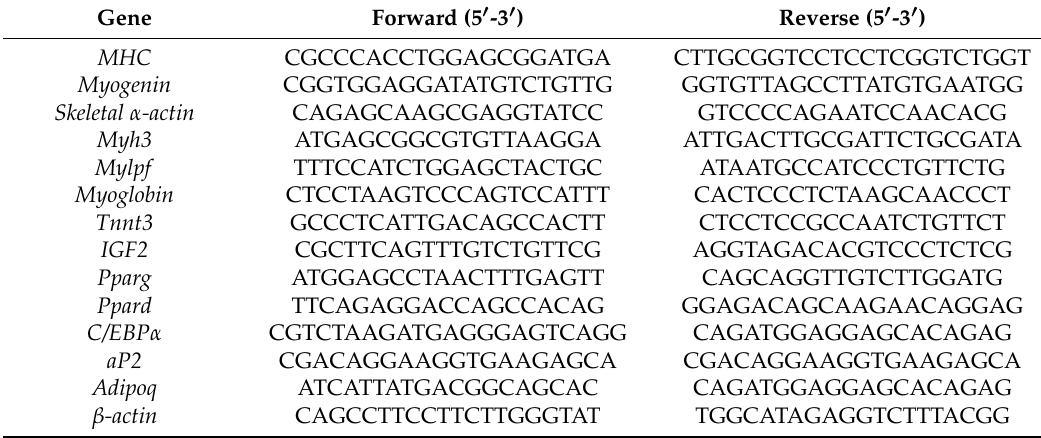
Table 1. Primer sequences used for real-time